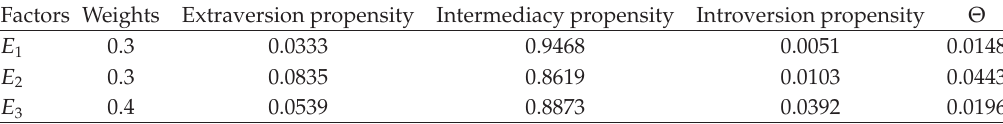
Table 4: Properties mass function.